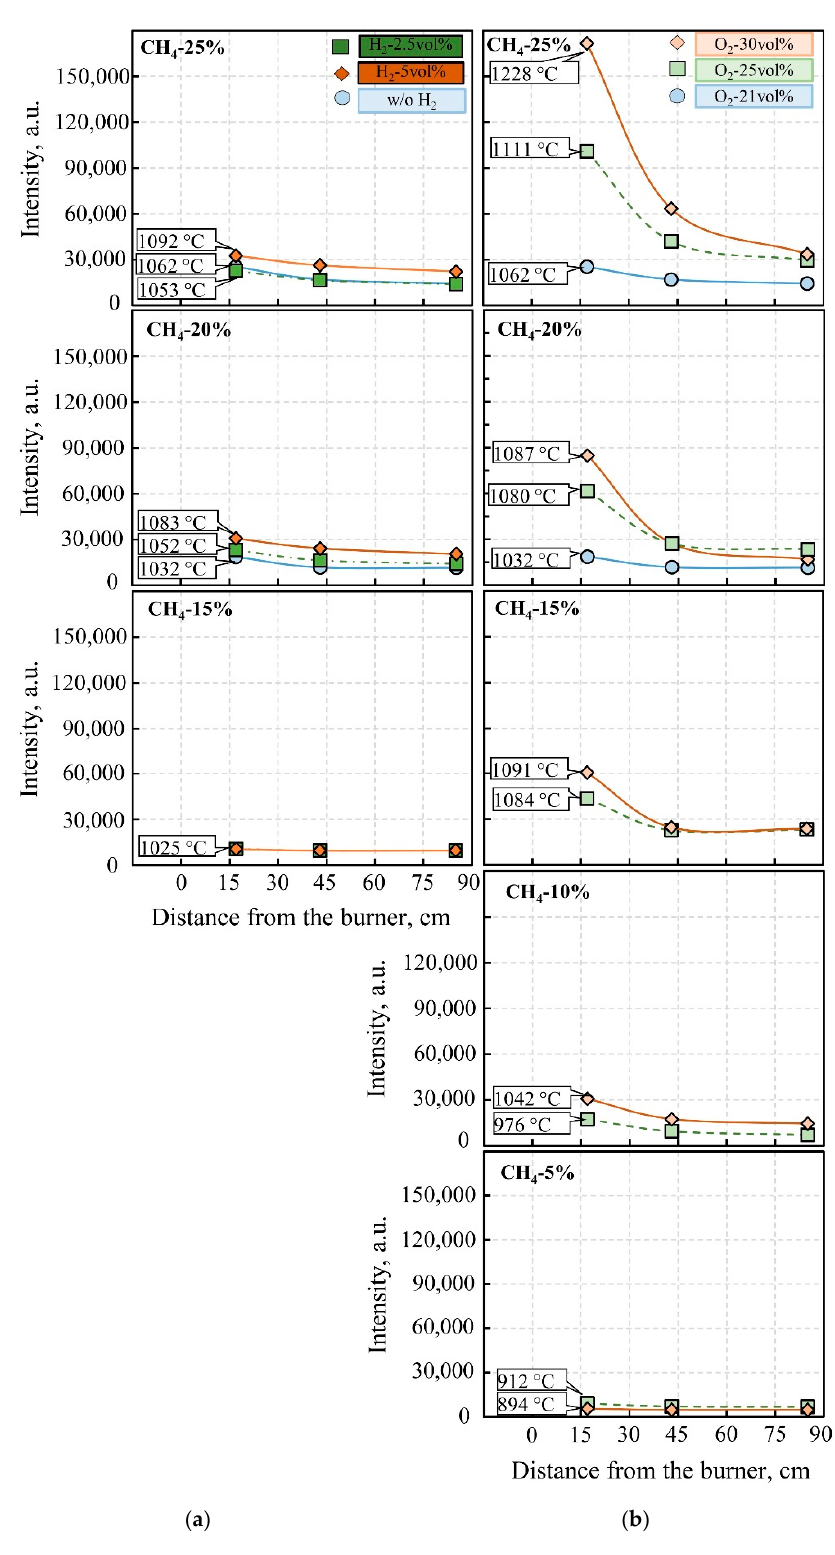
Figure 6. OH* spectral intensity distribution per distance at ϕ = 0.85 under ( a ) hydrogen-enrichment and ( b ) oxygen-enriched air.